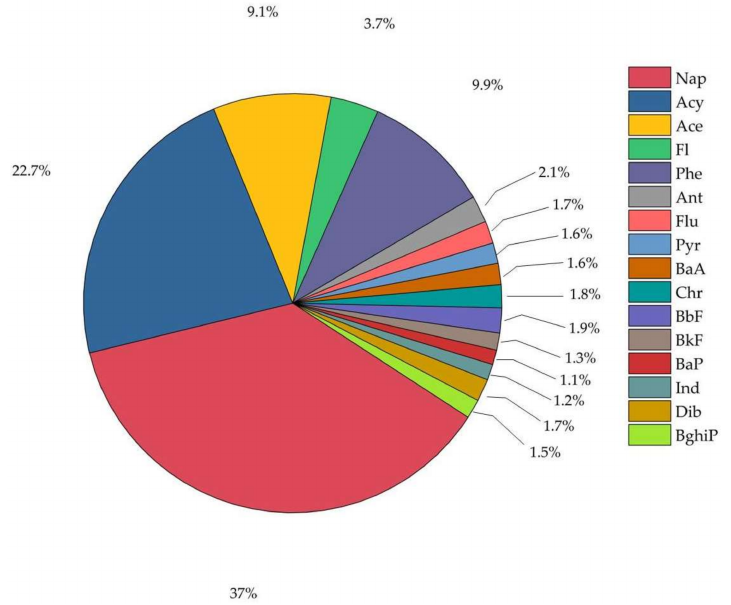
Figure 3. Relative contributions by PAH to the Σ 16 PAH observed in gas + PM 1 phases in the GMA expressed in